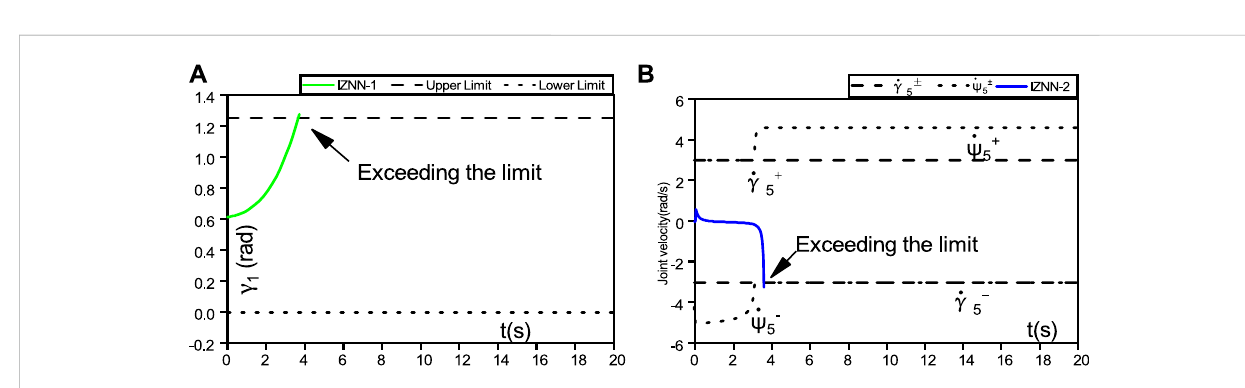
FIGURE 9 (A) represent joint angle fault for IZNN-1, (B) represent joint speed fault for IZNN-2.